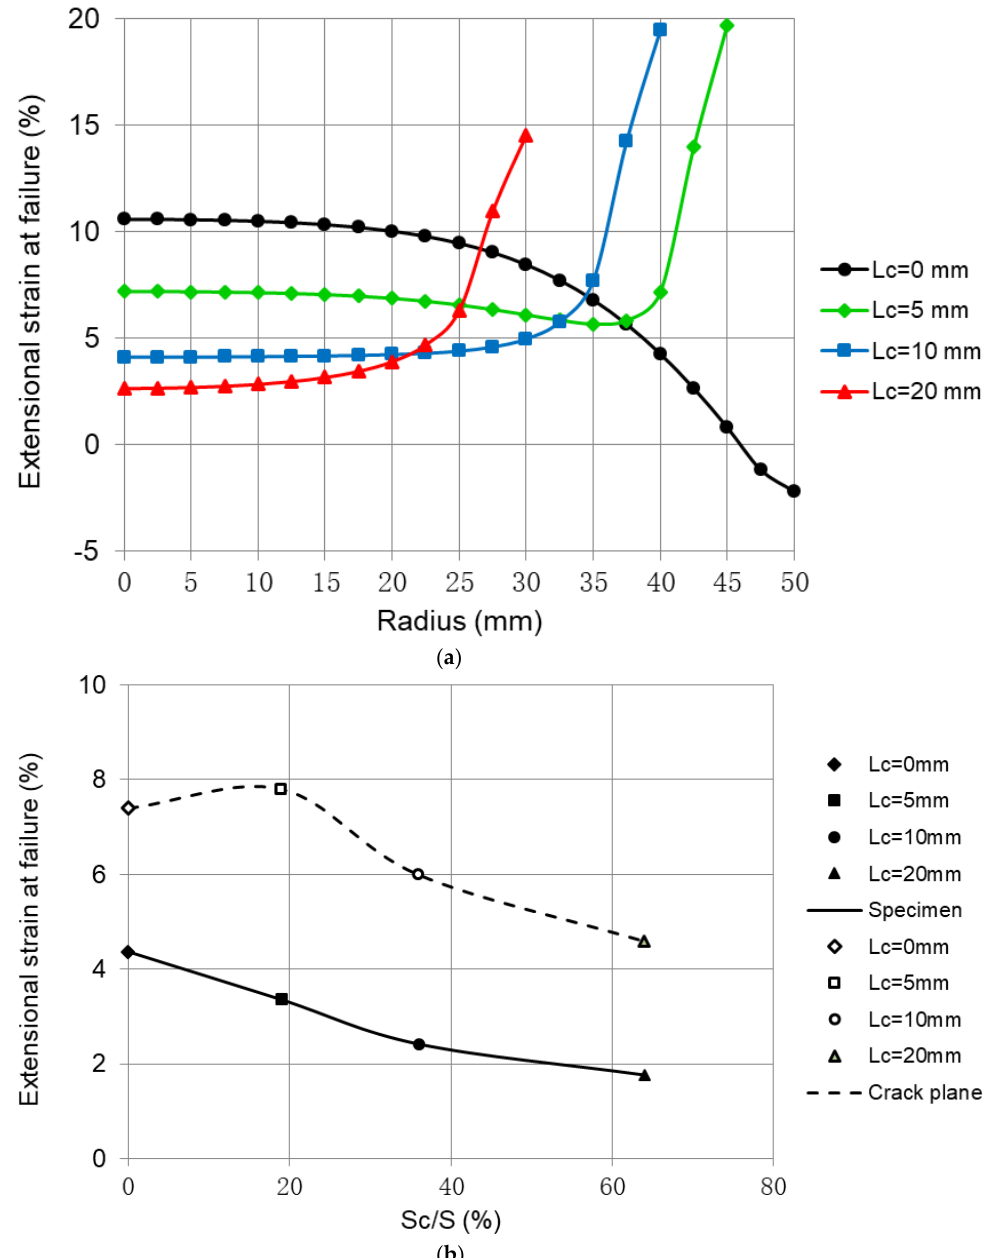
Figure 11. Extensional strains at failure of the asphalt specimens with different ring crack depths under the vertical displacement unrestraint conditions by applying step creep water pressure at 20 °C. ( a ) Extensional strains in the crack plane at failure; ( b ) Comparison of average extensional strains at failure of the specimens and in the crack plane.